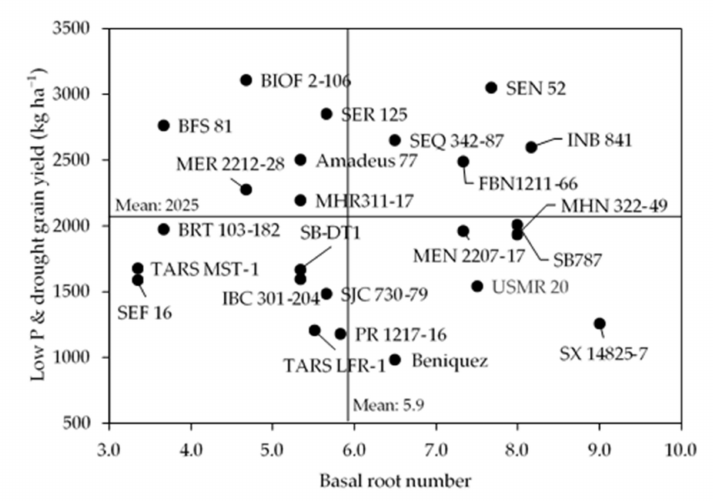
Figure 6. Genotypes with higher yield and basal root number grown under low P and drought treatment. The outstanding genotypes with higher yield and greater superior basal root number are in the upper right quadrant.